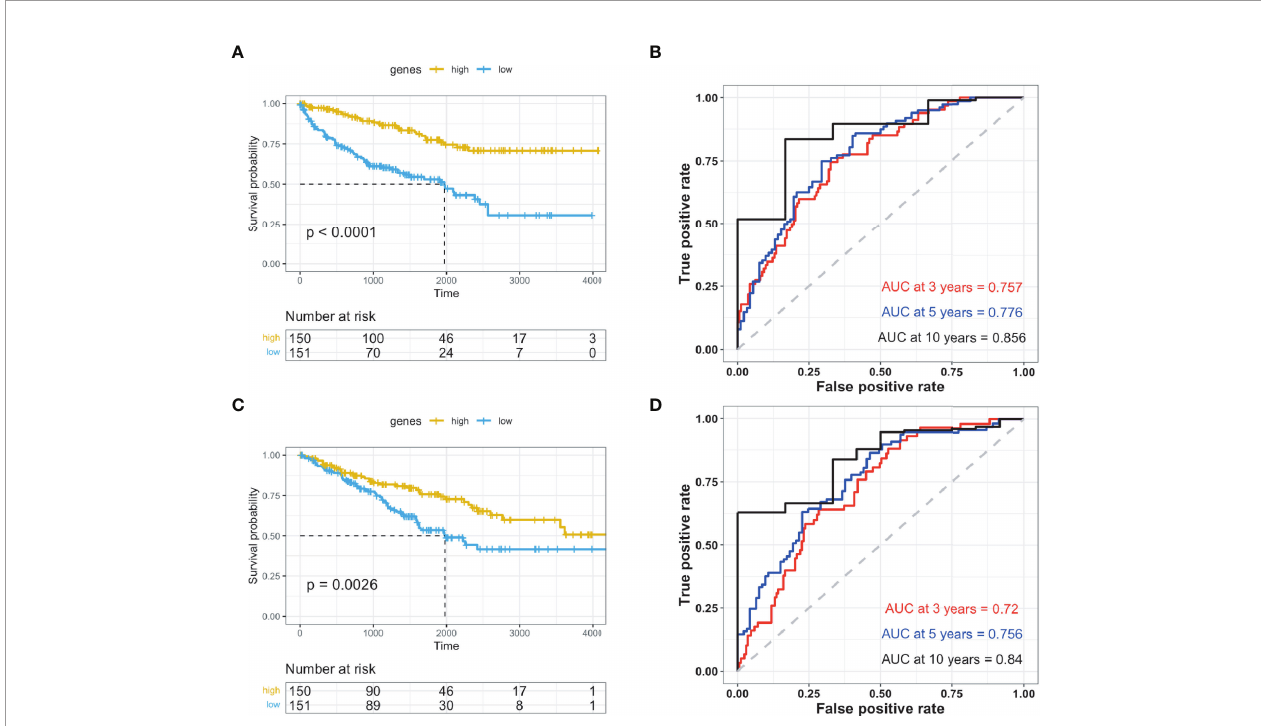
FIGURE 4 | Validation of prognosis genes for ccRCC. The prognostic genes were validated using Kaplan-Meier and receiver operating characteristic studies, and were divided into high- and low-risk groups. (A) Kaplan-Meier (KM) investigation of the risk group de fi ned with CD8+ T cell-correlated gene tags in The Cancer Genome Atlas (TCGA) training dataset for ccRCC. (B) 3-, 5-, and 10-year receiver operating characteristic (ROC) curves for TCGA training dataset of ccRCC. (C) Kaplan-Meier (KM) investigation of the risk group de fi ned with CD8+ T cell-correlated gene tags in the TCGA testing dataset for ccRCC. (D) 3-, 5-, and 10-year ROC curves for TCGA testing dataset of